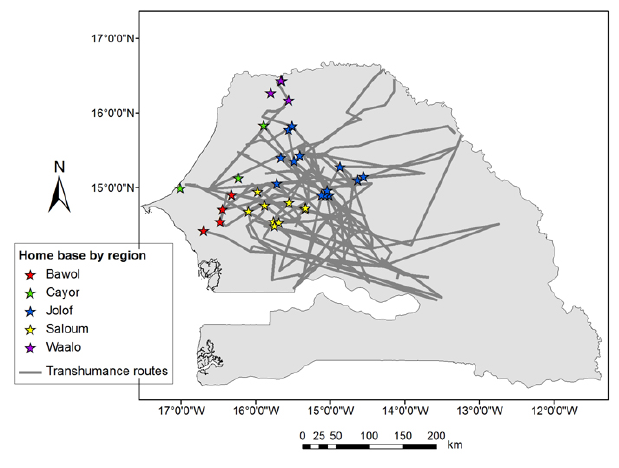
Fig. 1. Home communities and routes of transhumance of the informants, which determine the spatial extent of the study region. The home communities are color-coded by the historical region in which they